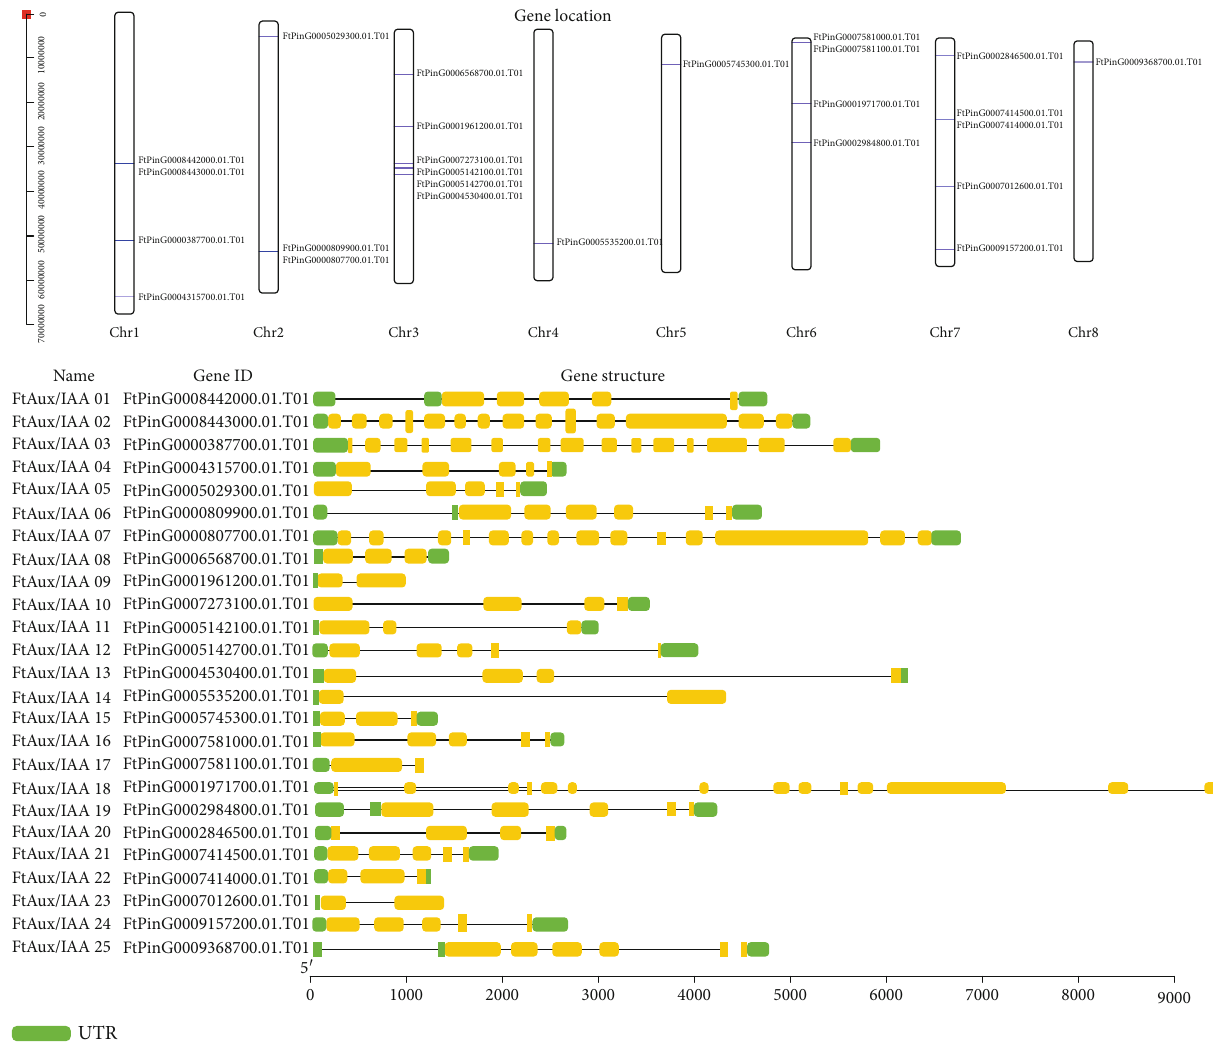
Figure 1: Distribution and gene structure of FtAux/IAA genes among eight chromosomes. Constrictions on the chromosomes (vertical bar) indicate the position of genes. The chromosome numbers and sizes (Mb) are indicated at the top of each bar. The UTR and exon-intron organization of the FtAux/IAA genes. The UTRs and exons and introns are represented by boxes and lines,